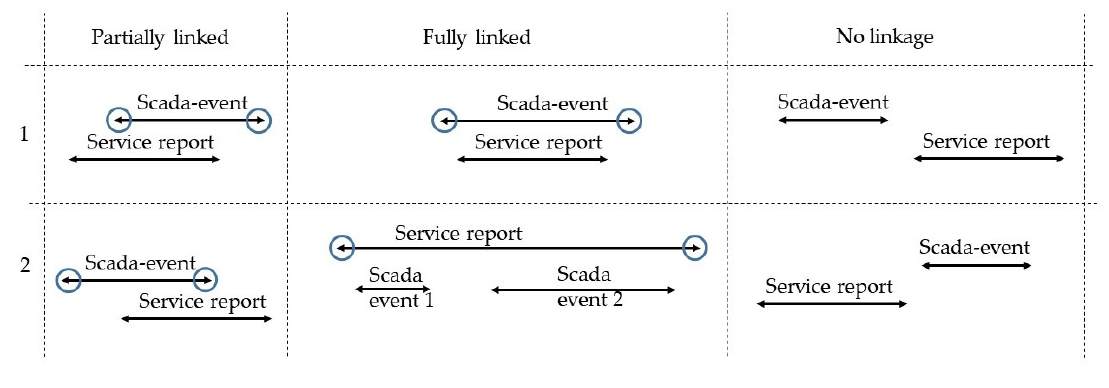
Figure 2. Validation of